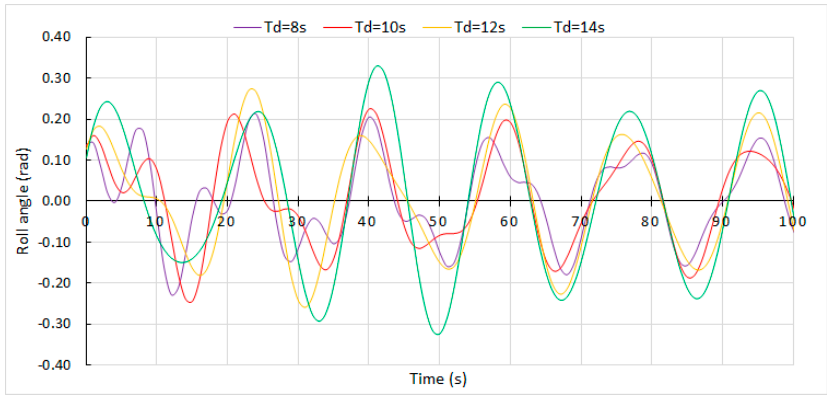
Figure 9. Simulation of the rolling angle for Tw = 18 s in the fi rst moments.